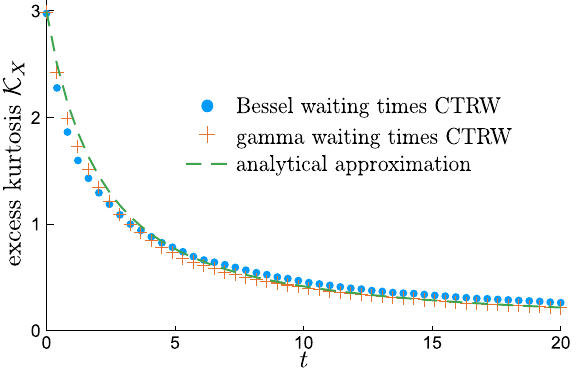
Figure 9. Excess kurtosis calculated from the simulations of CTRW with Bessel waiting times, gamma waiting times compared with the approximation (23),(25). This type of shape is shows relaxation from Laplace to Gaussian